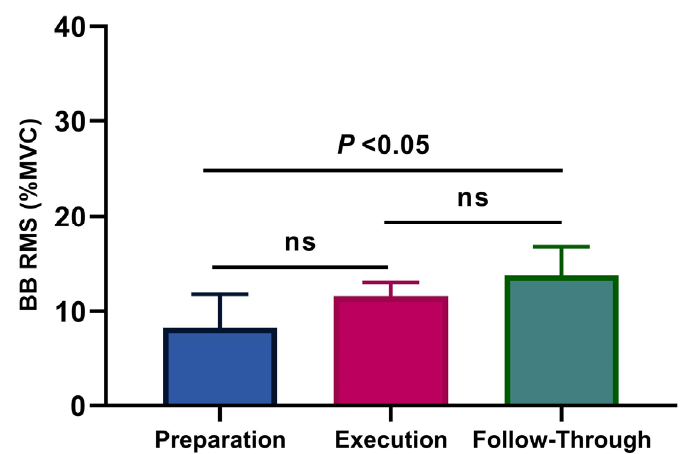
Figure 2. Average values and standard deviations for the normalized EMG (%MVC) per phase of the biceps brachii ( η 2 p = 0.50).